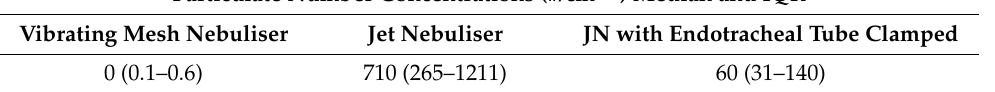
Table 1. Median and IQR (interquartile range) particulate number concentrations across all test runs detected for simulated drug refill at the two-minute mark.